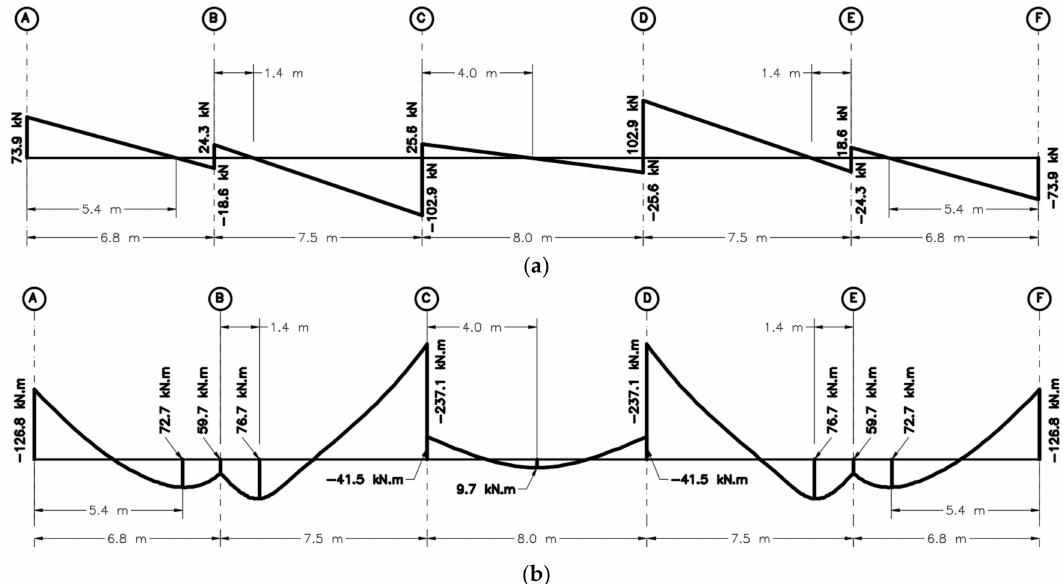
Figure 10. Efforts in beam V2 to the initial time instant t = 0: ( a ) shear force (kN); ( b ) bending moment (kN m).